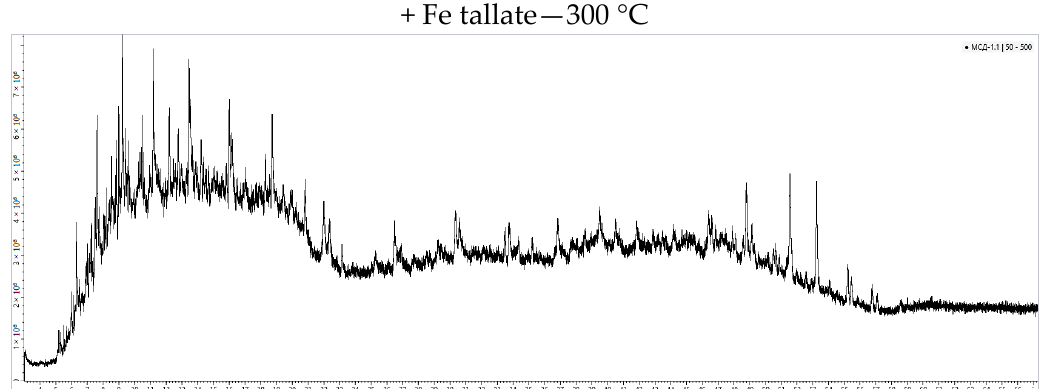
Figure 10. Total ionic current (TIC) chromatograms of the saturated fraction. As a result of thermal steam treatment at temperatures of 200 and 250 °C as well as in the presence of the catalyst iron tallate, the content of n- and iso-alkanes increases in comparison with the original oil and with the control experiments. The content of alkanes in the samples after TST at 300 °C increases by 8 times in comparison with the original oil, and the content of cycloalkanes in the sample with catalyst increases by 2 times in com- parison with the control experiments. This could indicate the breaking not only of carbon heteroatom bonds (C-S, N, O) but also of C-C bonds (Figure 11).